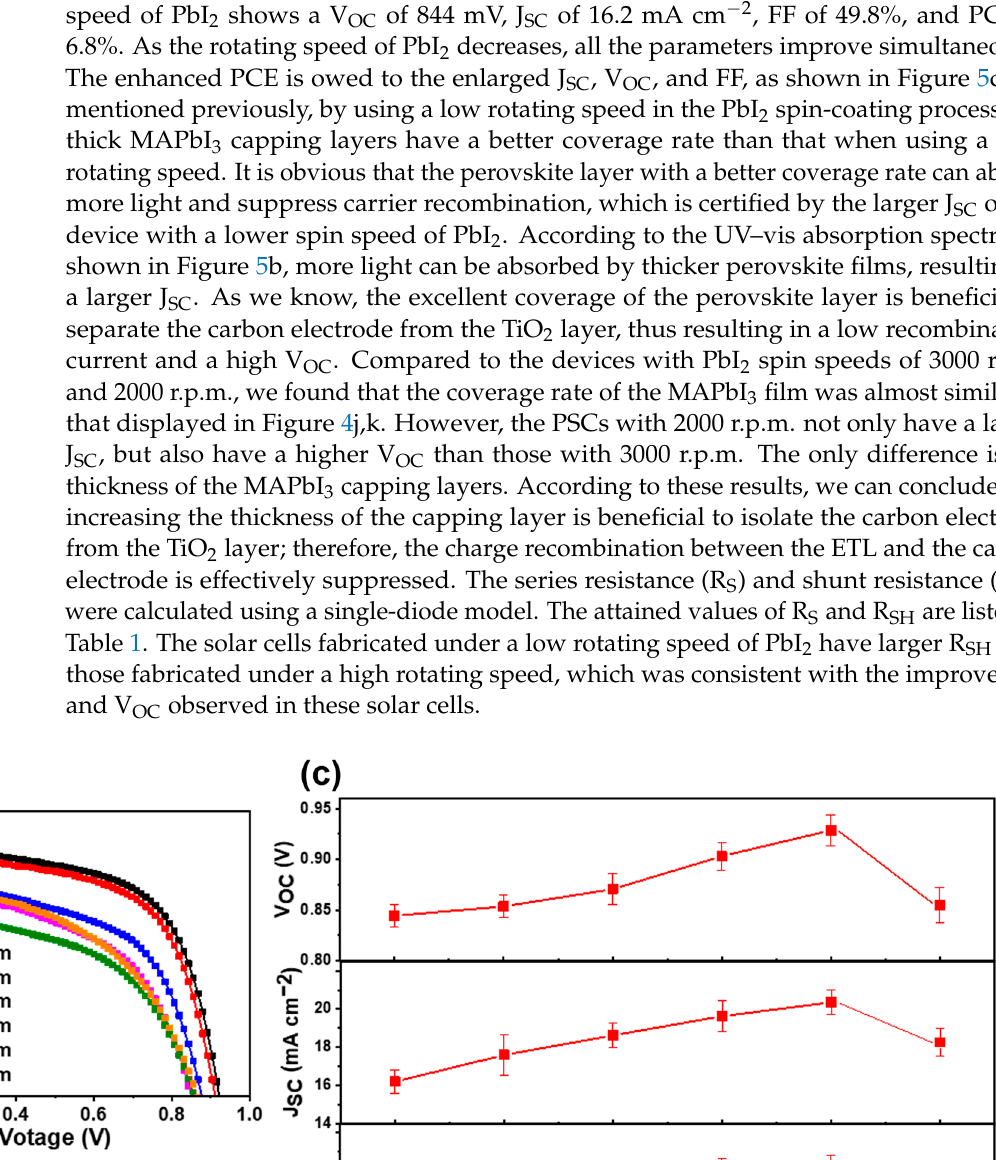
Figure 5. ( a ) J–V curves of perovskite solar cells prepared with PbI 2 films under different spin-coating speeds from 6000 r.p.m. to 1000 r.p.m. ( b ) UV–vis absorption spectra of MAPbI 3 films prepared under different spin-coating speeds of 6000, 4000, and 2000 r.p.m. for PbI 2 films. ( c ) Variations in V OC , J SC , FF and PCE under different spin-coating speeds from 6000 r.p.m. to 1000 r.p.m.